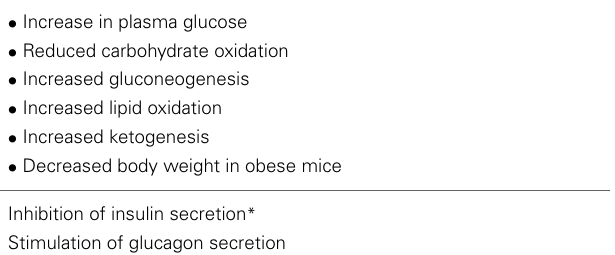
Table 1 | Metabolic and endocrine effects of